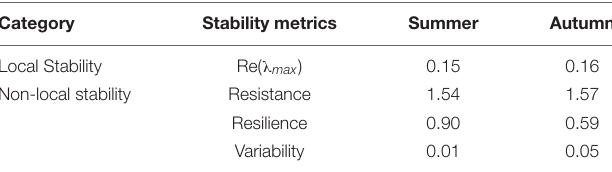
TABLE 3 | Food web stability of artificial reef of Juehua Island in summer and autumn of 2019.